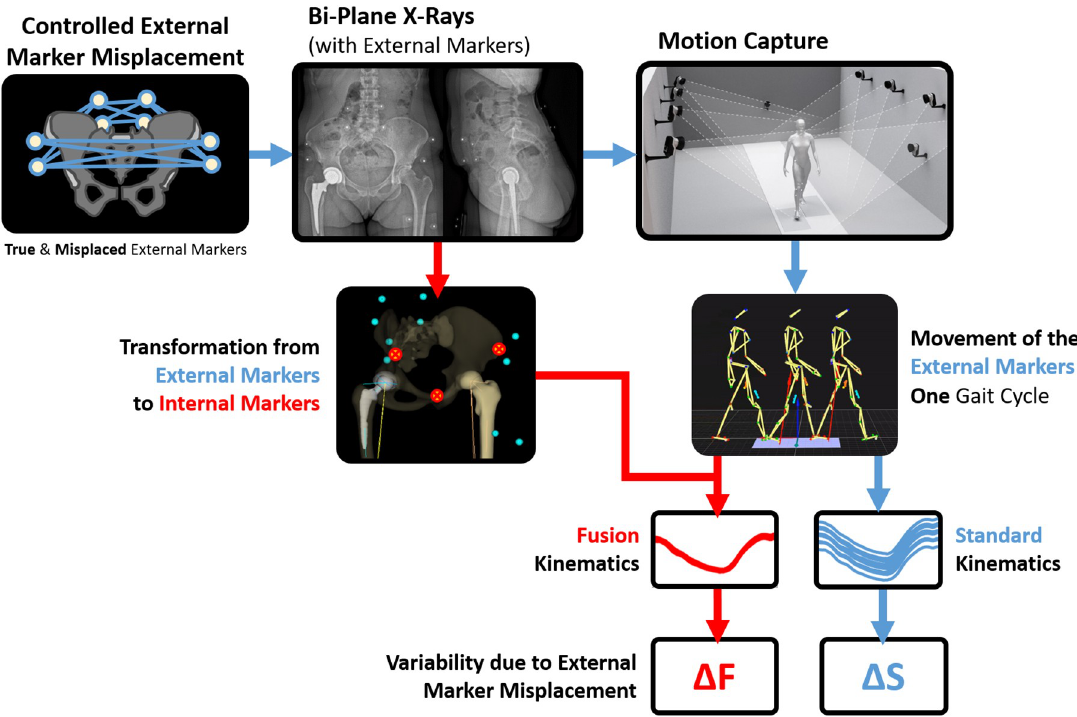
Fig 1. Workflow of the standard method and fusion